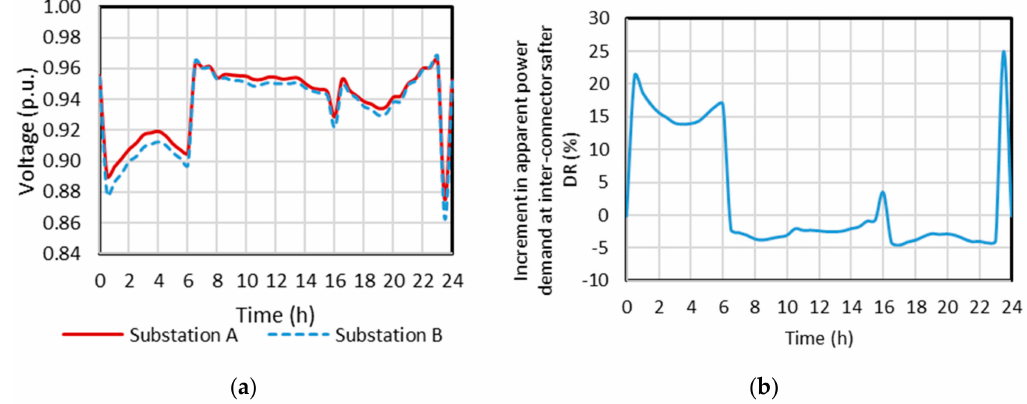
Figure 15. ( a ) Secondary voltage at transformers of both substations and ( b ) increment in apparent power flow through inter-connectors after the implementation of DR for scenario